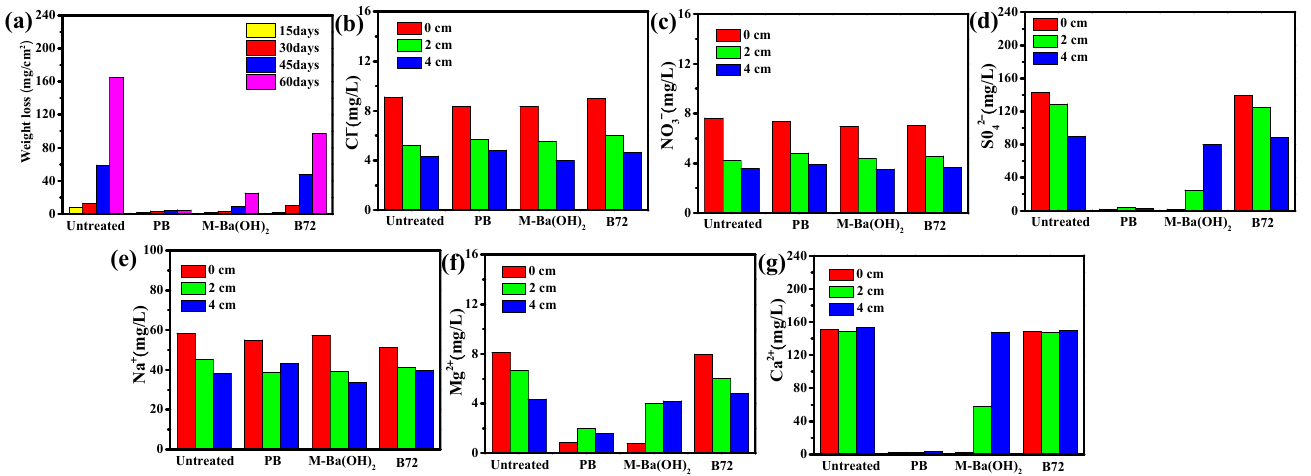
Figure 7. ( a ) Weight loss of simulated samples of soluble salt/pigment/consolidation system after PB, M-Ba(OH) 2 , and B72 treatment. The concentrations of ( b ) chloride ions, ( c ) nitrate ions, ( d ) sulfate ions, ( e ) sodium ions, ( f ) magnesium ions, and ( g ) calcium ions in the simulated samples after PB, M-Ba(OH) 2 , and B72 treatment.